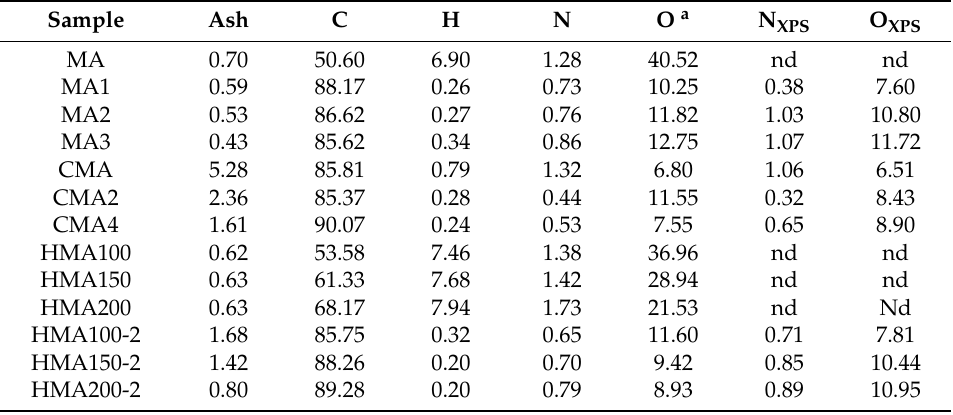
Table 2. Ash content (%), ultimate analysis (wt %) in dry basis, and N and O contents (wt %) from X-ray photoelectron spectroscopy (XPS) of the raw material, precursors, and activated carbons.